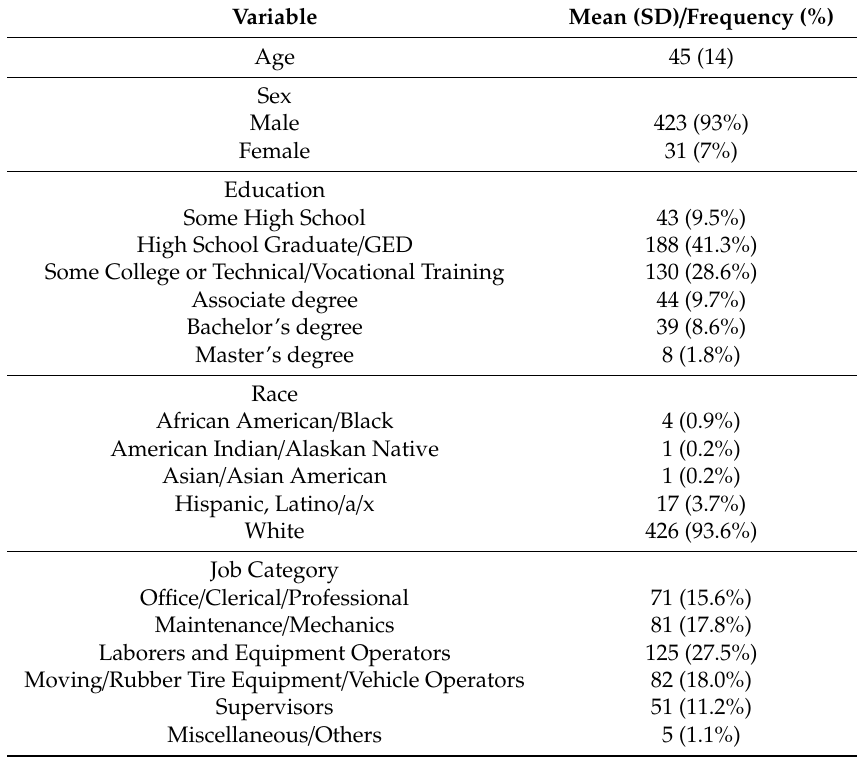
Table 1. Descriptive statistics of respondents’ sociodemographic characteristics and job